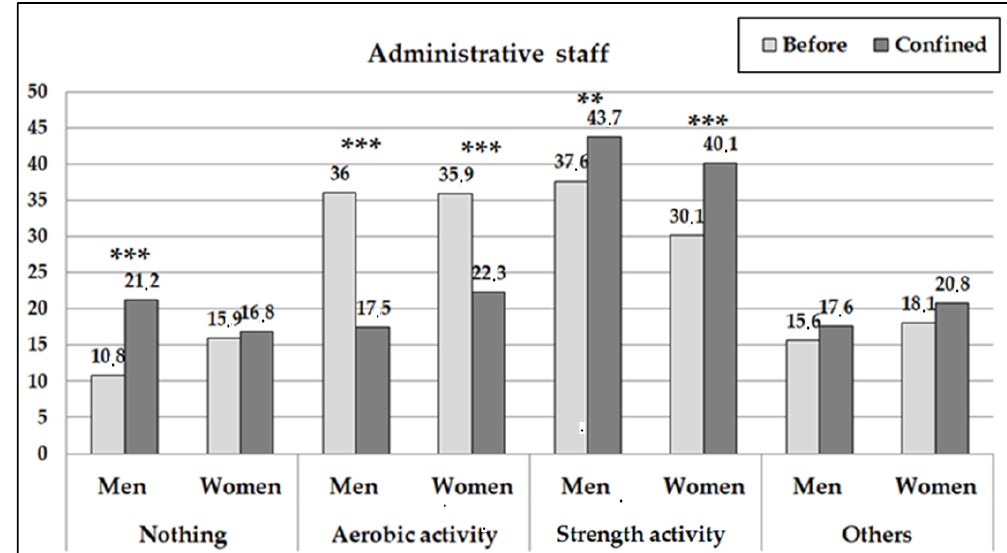
Figure 3. Percentages of administrative workers who carried out physical activity according to the type of physical activity carried out before and after the confinement. (The asterisks indicate the significant differences before and during confinement by sex subgroup: ** p < 0.01; *** p < 0.001).